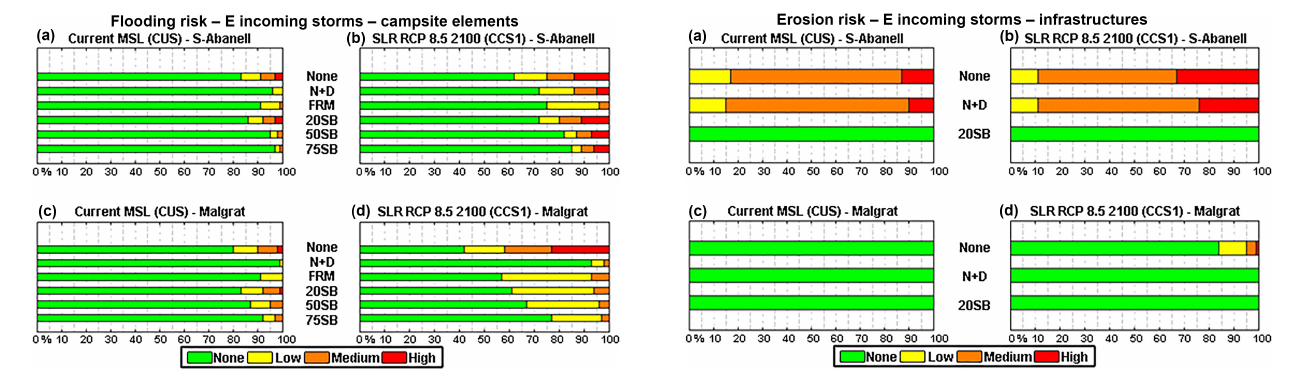
Figure 13. Distribution of Infrastructures at every level erosion risk: (a) current scenario at S’Abanell; (b) climate change scenario 1 (SLR) at S’Abanell; (c) current scenario at Malgrat; (d) climate change scenario 1 (SLR) at Malgrat. Each bar in a panel repre- sents a risk reduction configuration (’“none”’: no measure imple- mented; “N + D”: nourishment and dune; “FRM”: flood resilience measures; “20SB, 50SB, and 75SB”: 20, 50, and 75m setbacks, re-